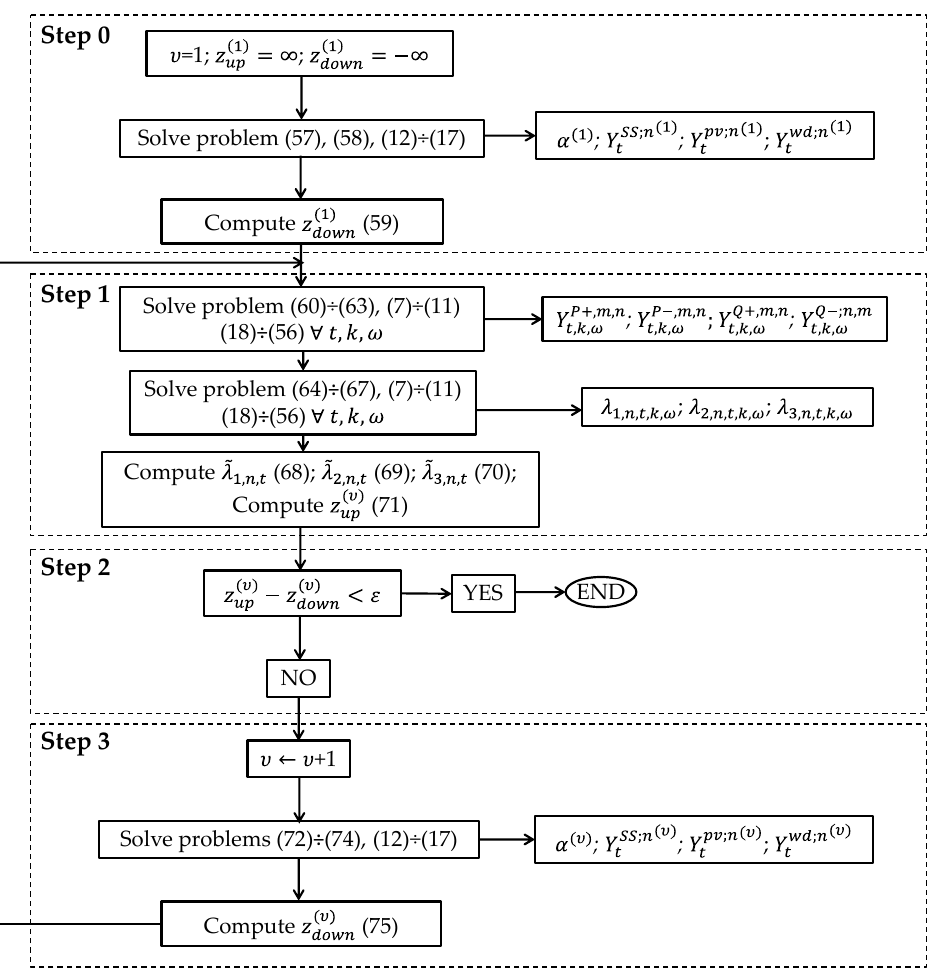
Figure 1. Benders’ decomposition flowchart.